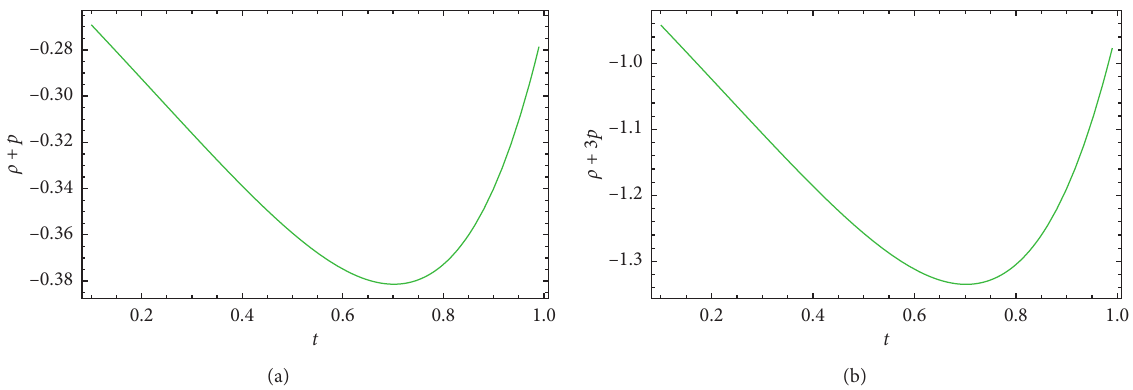
Figure 8: Evolution of NEC and SEC for ω − 0 . 0005 ; s � 5.